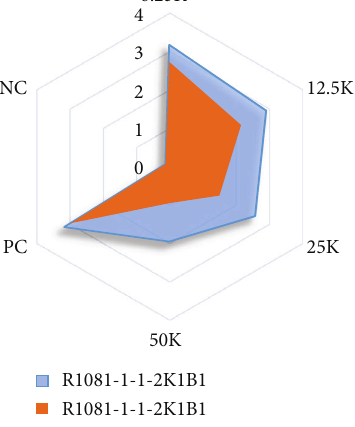
Figure 4: AcrB antibody